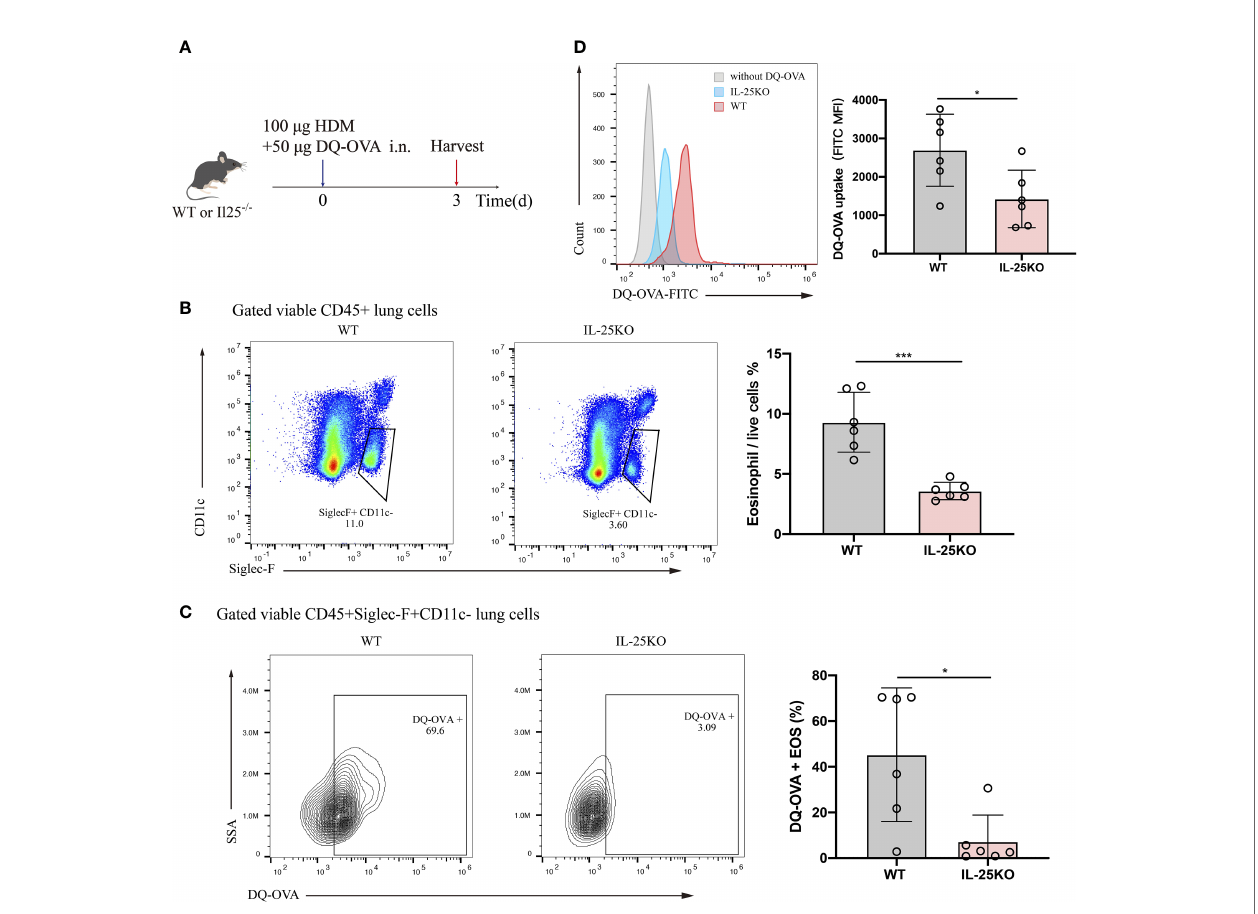
FIGURE 5 | IL-25 de fi ciency reduced mouse antigen uptake by pulmonary eosinophil in vivo . (A) Schematic representation of IL-25KO and littermate WT mice receiving traceable DQ-OVA together with HDM injection intranasally (n = 6 per group), followed by an analysis on day 3. (B) The fl ow plots and statistical analysis of eosinophils in fi ltration in lungs of mice as in (A) . (C) Analysis for DQ-positive eosinophils in the lung of mice as in (A) . (D) MFI values of DQ-OVA for eosinophils in the lung of mice as in (A) . n = 6. Unpaired Student ’ s t test (B – D) , *p < 0.05, ***p <